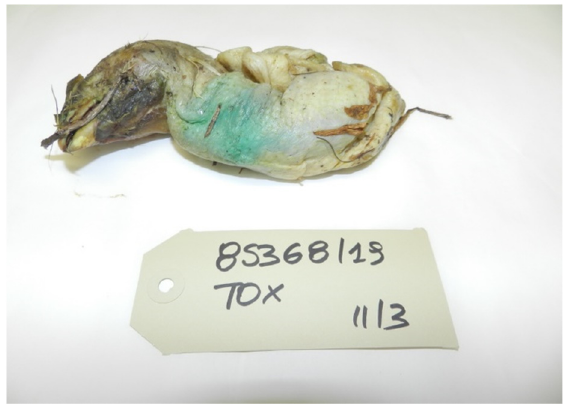
Figure 9. Chicken carcass with blue–green coloring.